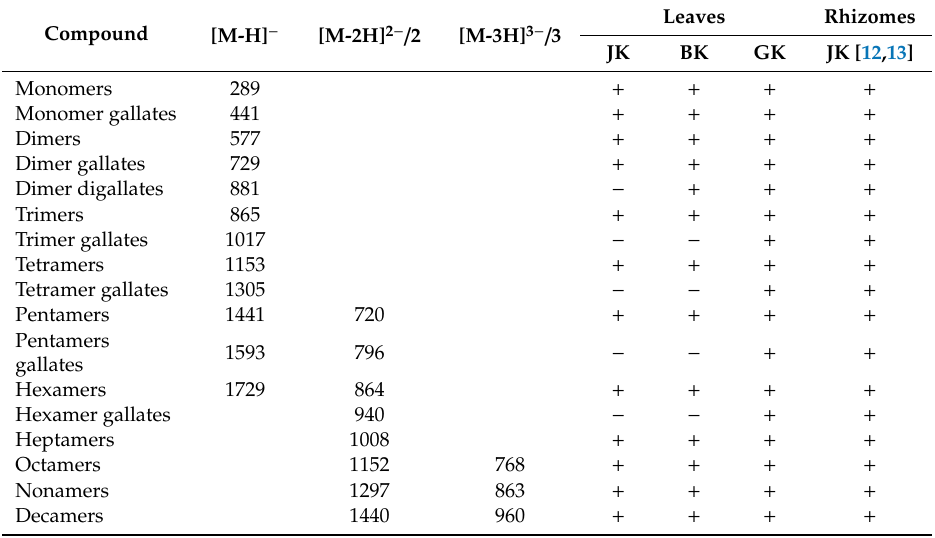
Table 3. Proanthocyanidins identified with HPTLC–MS / MS analyses of leaves of Japanese knotweed ( JK ), Bohemian knotweed ( BK ) and giant knotweed ( GK ). HPTLC diol F 254S plates were pre-developed and developed (up to 9 cm) with